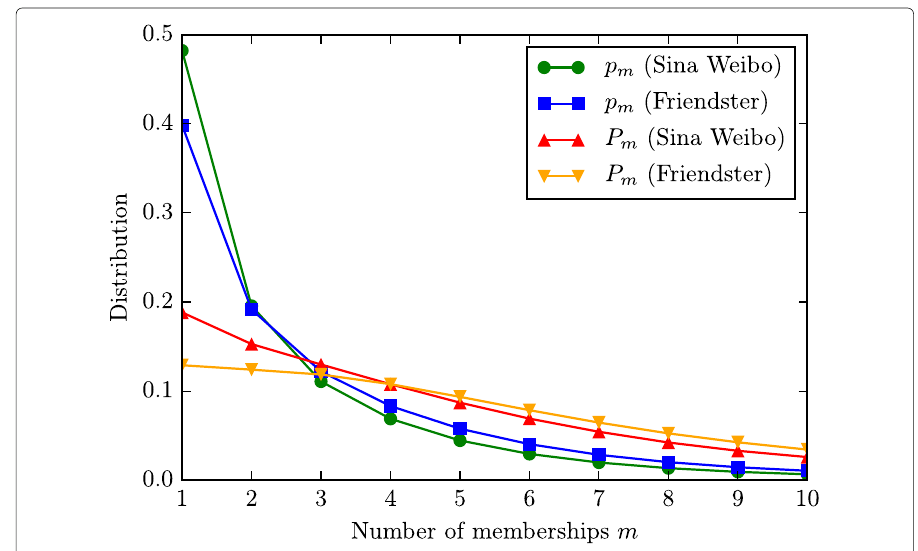
Fig. 2 Membership distribution p m of vertices with m (cid:2) 1 and the empirical probability P m that amemberof acommunity has m memberships. P m is right skewed because a vertex with m memberships is counted